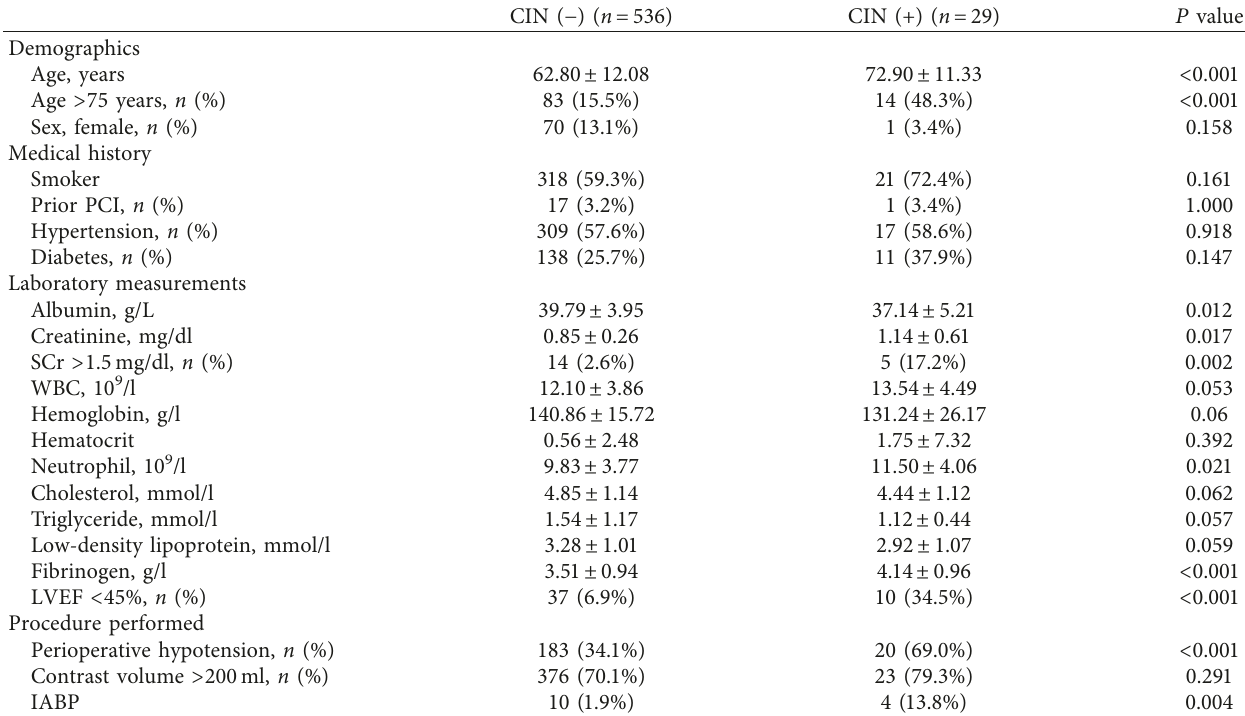
Table 1: Baseline clinical features in patients with and without CIN.